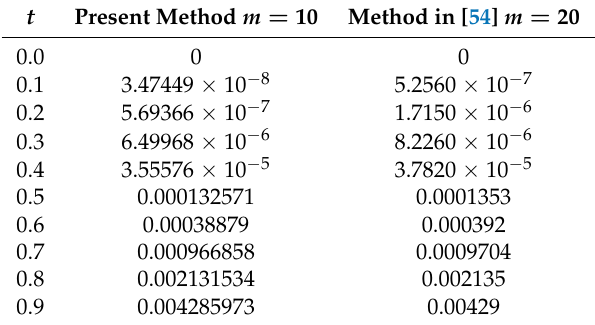
Table 4. Comparison of absolute errors for Example 3.